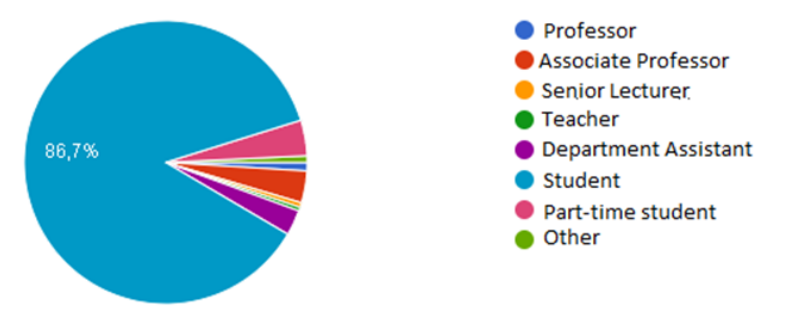
Figure 6: Distribution of respondents depending on the position / form of education.